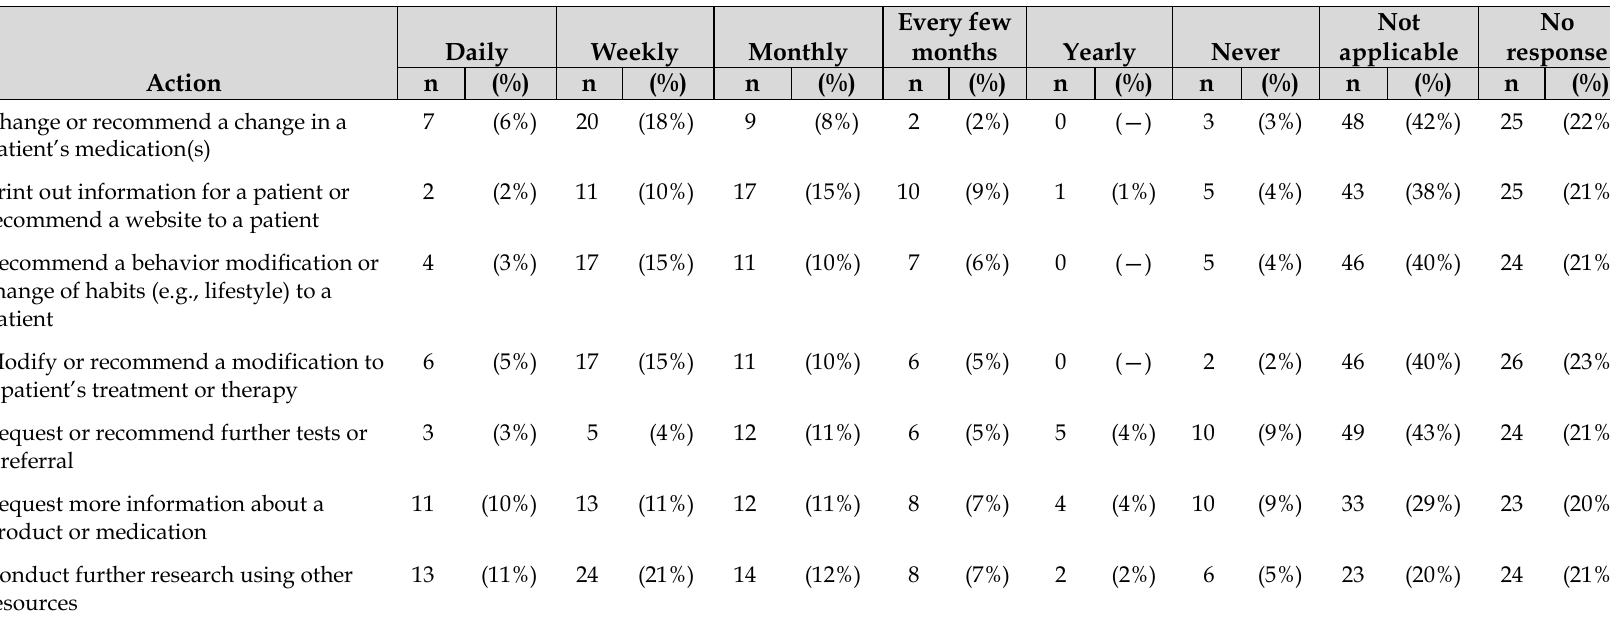
Table 2 Survey respondents’ indications of how frequently they carry out the following actions as a result of obtaining clinical information from the